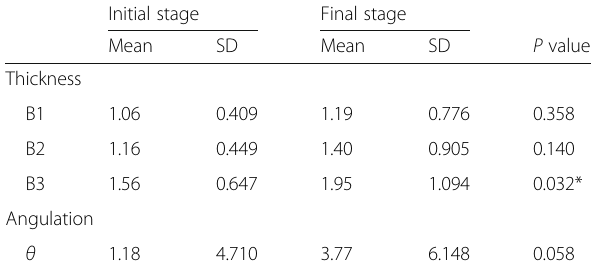
Table 1 Comparison of mean labial alveolar bone thickness and angulation at initial and final stage